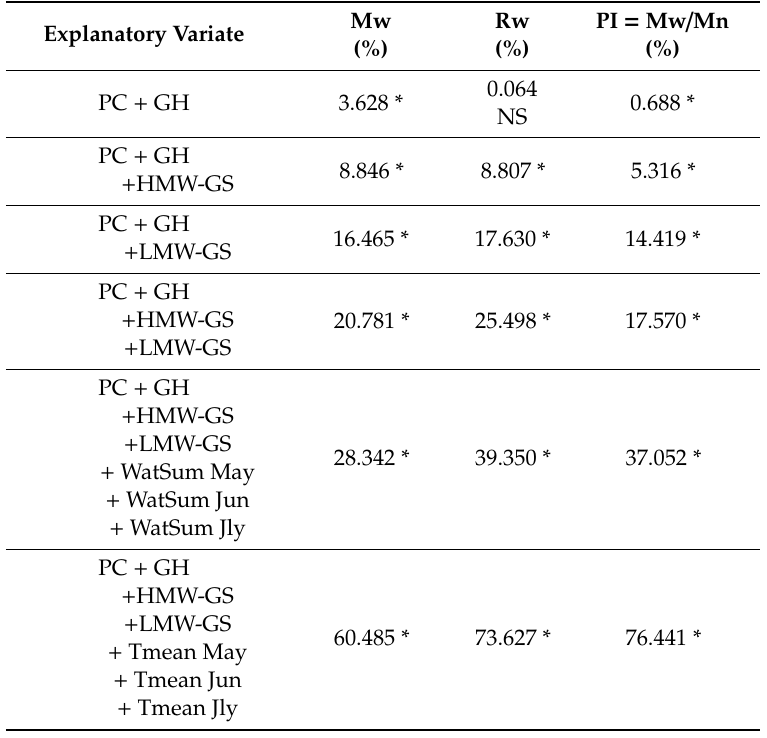
Table 2. Partial least square (PLS) regression: Part of the phenotypic variance of molecular mass